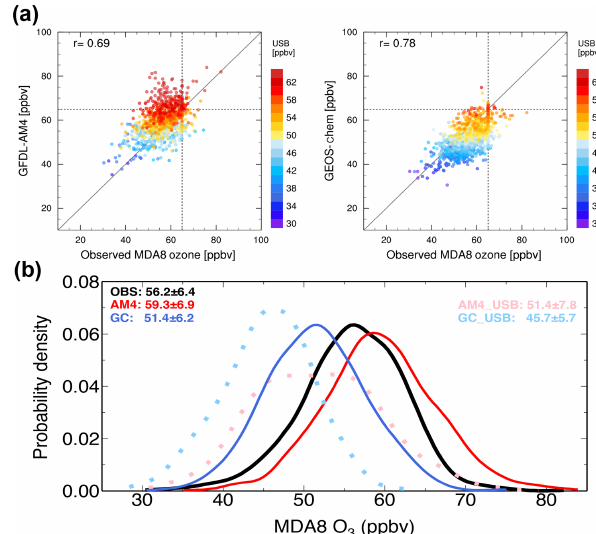
Figure 17. (a) Scatterplots of observed versus simulated daily MDA8 O 3 , color-coded by USB O 3 , at 12 WUS high-elevation sites (circles in Fig. 1a) during April–June 2017. The dashed lines mark the 65ppbv threshold. (b) Probability density of daily MDA8 O 3 as observed (solid black) and simulated with GFDL-AM4 (solid red) and GEOS-Chem (solid blue), along with the distribution of USB O 3 estimated from each model (dotted